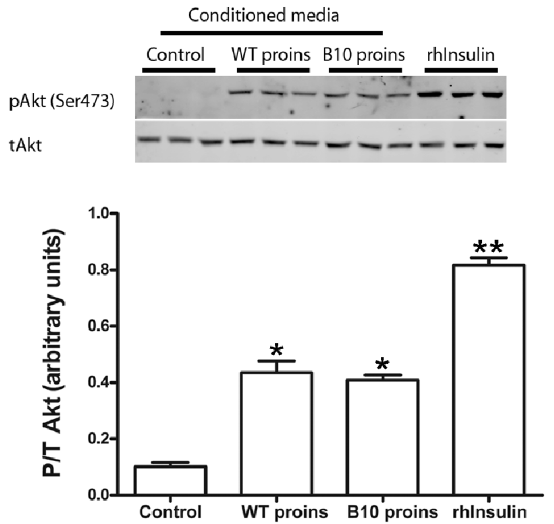
Figure 2. Human Proinsulin-WT and Proinsulin-B10 expressed by transduced HEK293 cells is bioactive invitro . Confluent HEK293 cells were switched to serum-free medium with or without rAd-proinsulin-WT or rAd-proinsulin-B10; 24 h later, conditioned media (CM) were collected and hProinsulin concentration was determined by ELISA. Fresh HEK293 cells were seeded, serum starved for 2 h, and treated for 15 min with Control CM (no vector), 10 nM hProinsulin-WT CM (WT proins), 10 nM hProinsulin-B10 CM (B10 proins) or 10 nM recombinant human insulin (rhInsulin). Protein lysates were collected and analyzed by western immunoblot for phospho-Akt(Ser473) and total Akt. Immunoblot band intensities were measured and bars indicate mean + SEM of the P/T Akt ratio for n=3 samples; *, P , 0.0001 vs. control, **, P , 0.0001 vs. all (ANOVA).